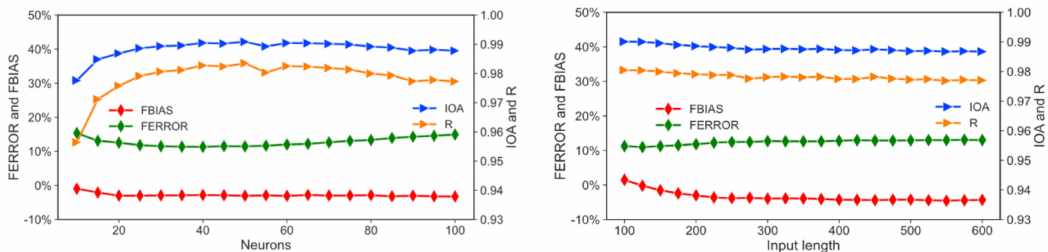
Figure 3. The performance variations with neuron number ( left ) and the length of input sample length ( right ).